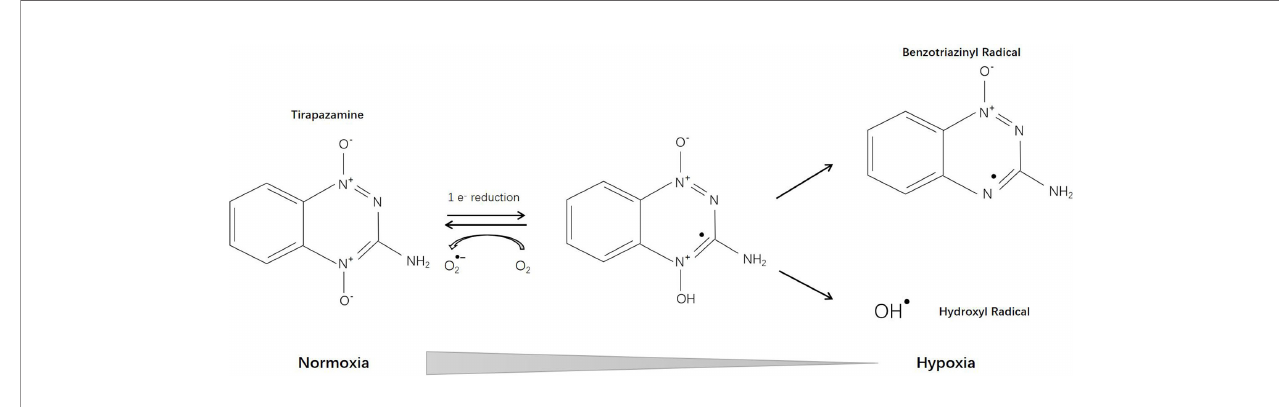
FIGURE 2 | Reductive reaction of tirapazamine.